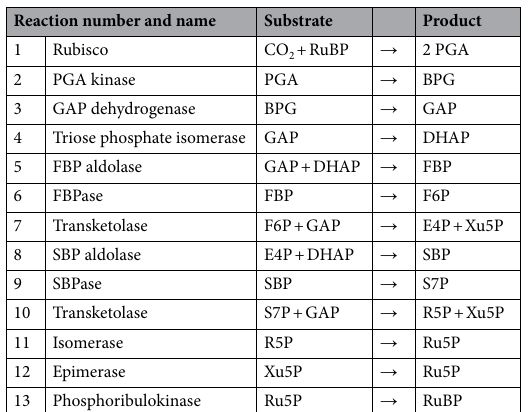
Table 1. List of reactions constituting the canonical Calvin–Benson cycle a,b,c . a Currency metabolites are not shown. Currency metabolites include metabolites such as ATP, ADP, NADPH, NADP + , H + , inorganic phosphate, and H 2 O. b PGA kinase, 3-phosphoglycerate kinase; GAP dehydrogenase, glyceraldehyde